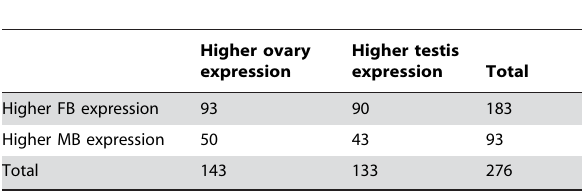
Table 3. Genes* with sexually dimorphic co-expression in both the gonads and the brains.